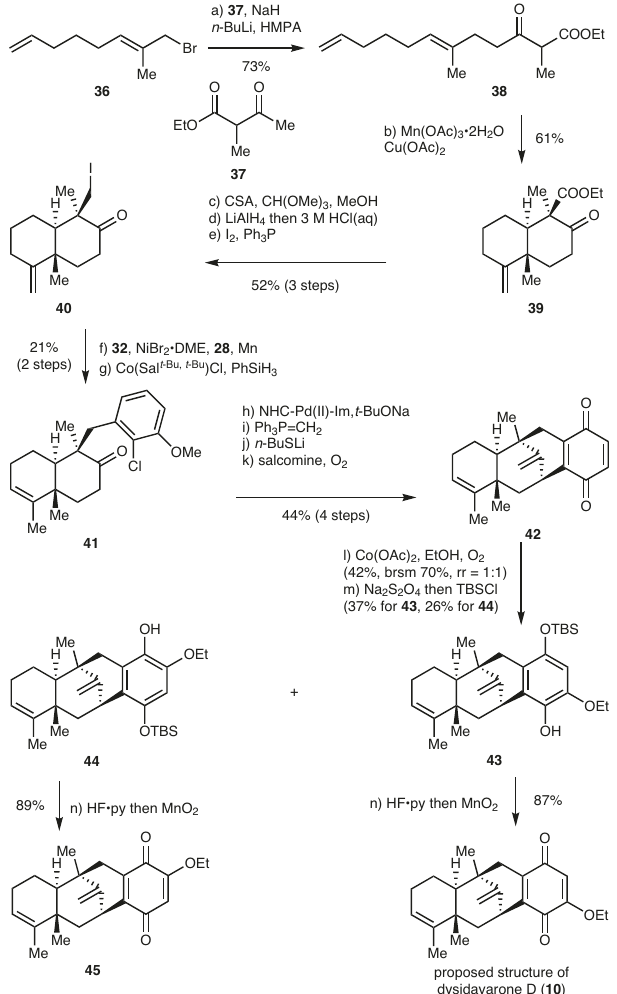
Fig. 5 | Synthesis of proposed structure of dysidavarone D. Reagents and con- ditions: a NaH(5.0equiv), n -BuLi(5.0equiv), 37 (5.0equiv),HMPA(1.2equiv),THF, 23°C, 1h, 73%; b Mn(OAc) 3 ·2H 2 O (2.0 equiv), Cu(OAc) 2 (1.1 equiv), AcOH, 40°C, 24h, 61%; c CH(OMe) 3 (7.5 equiv), CSA (0.10 equiv), MeOH, 23°C, 4.5h, 81%; d LiAlH 4 (4.0equiv),THF,15h,then3MHCl,23°C,1h,75%; e PPh 3 (1.3equiv),I 2 (1.2 equiv), imidazole (2.0 equiv), benzene, 40°C, 15h, 85%; f NiBr·DME (1.5 equiv), 28 (1.5 equiv), Mn (3.0 equiv), 32 (3.0 equiv), DMAc, 17h; g Co(Sal t -Bu, t -Bu )Cl